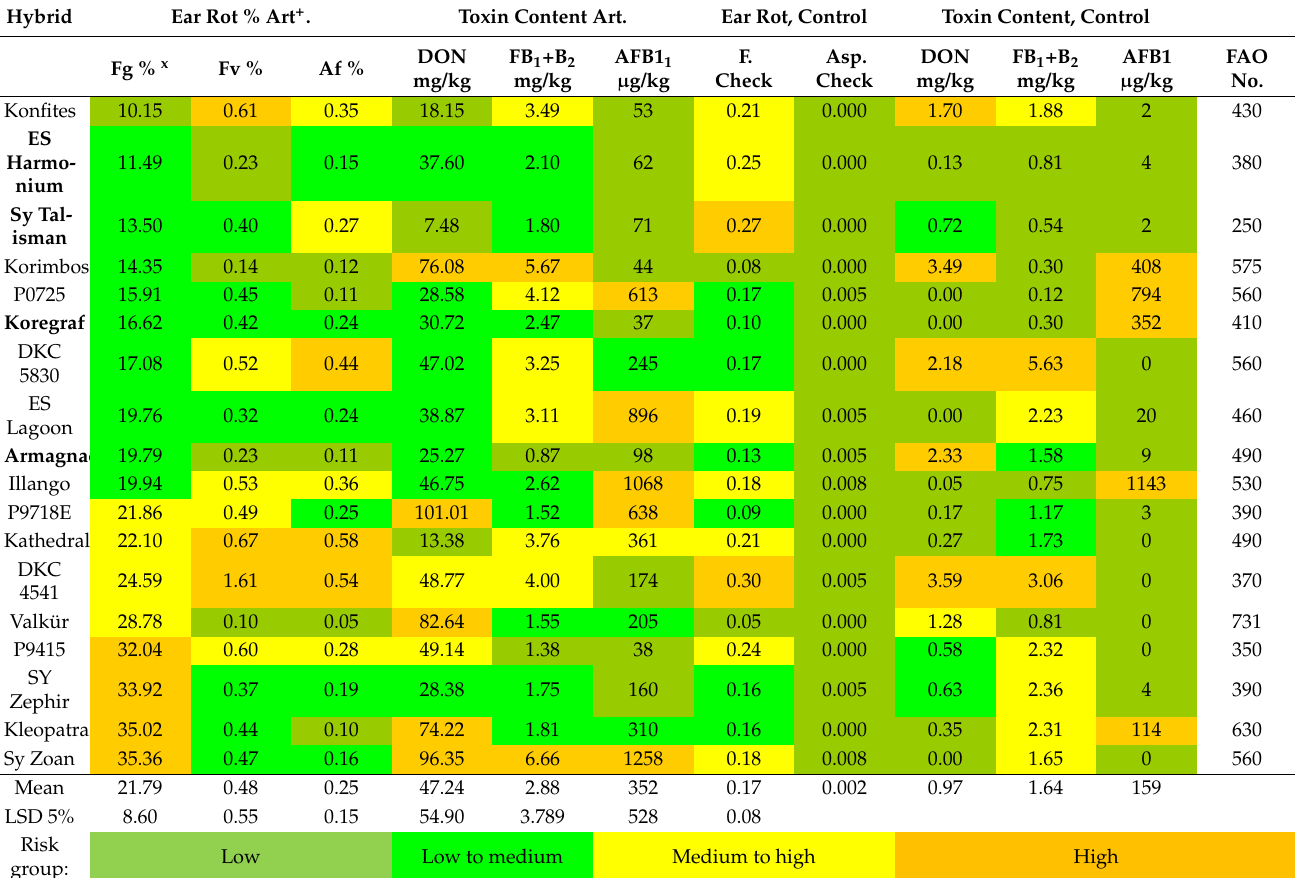
Table 6. Kernel resistance tests of maize hybrids to toxigenic fungi. Summary of the second maize kernel resistance test and toxin analyses against three toxigenic fungi,